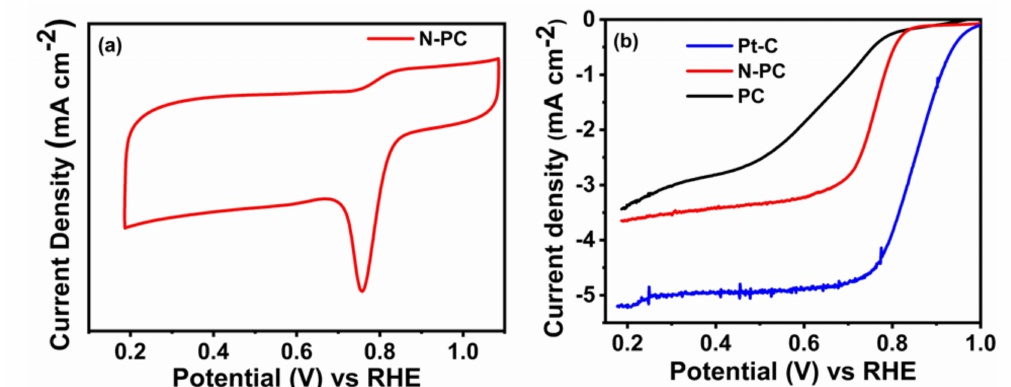
Figure 6. ( a ) CV curves of N-PC in O 2 saturated; ( b ) LSV curves of PC, N-PC and Pt-C obtained